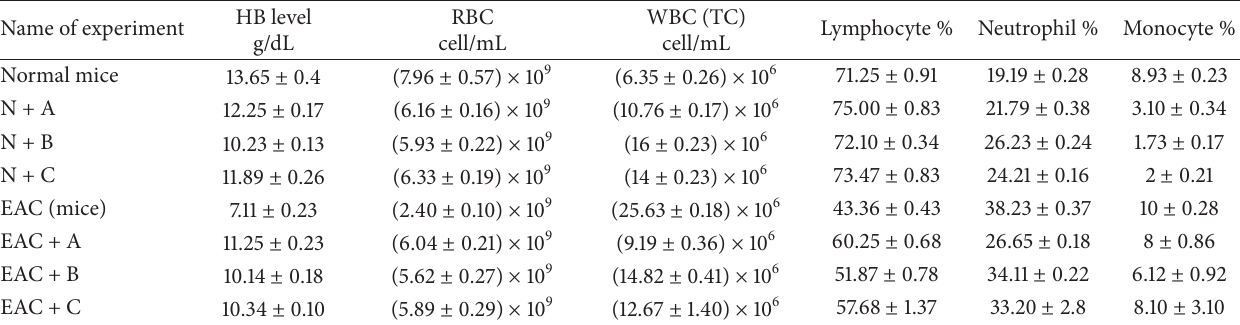
Table 7: The effect of test compounds on hematological parameters in normal and tumour bearing